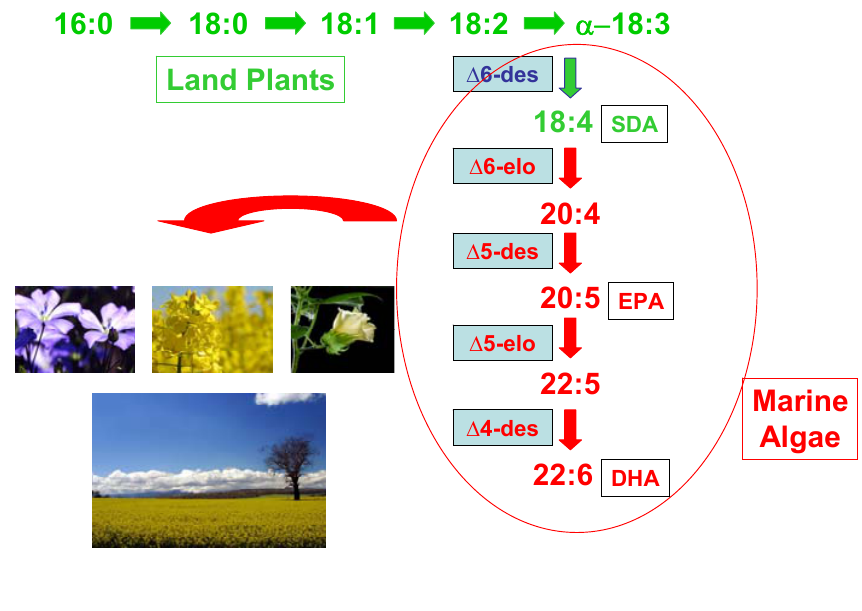
Figure 1 . Schematic representation of fatty acid pathway for new land plants containing EPA and DHA, with incorporation on selected microalgae-derived genes. Although the Δ 6 route is shown here, another pathway for LC omega-3 biosynthesis ( Δ 9, from ALA) also exists.